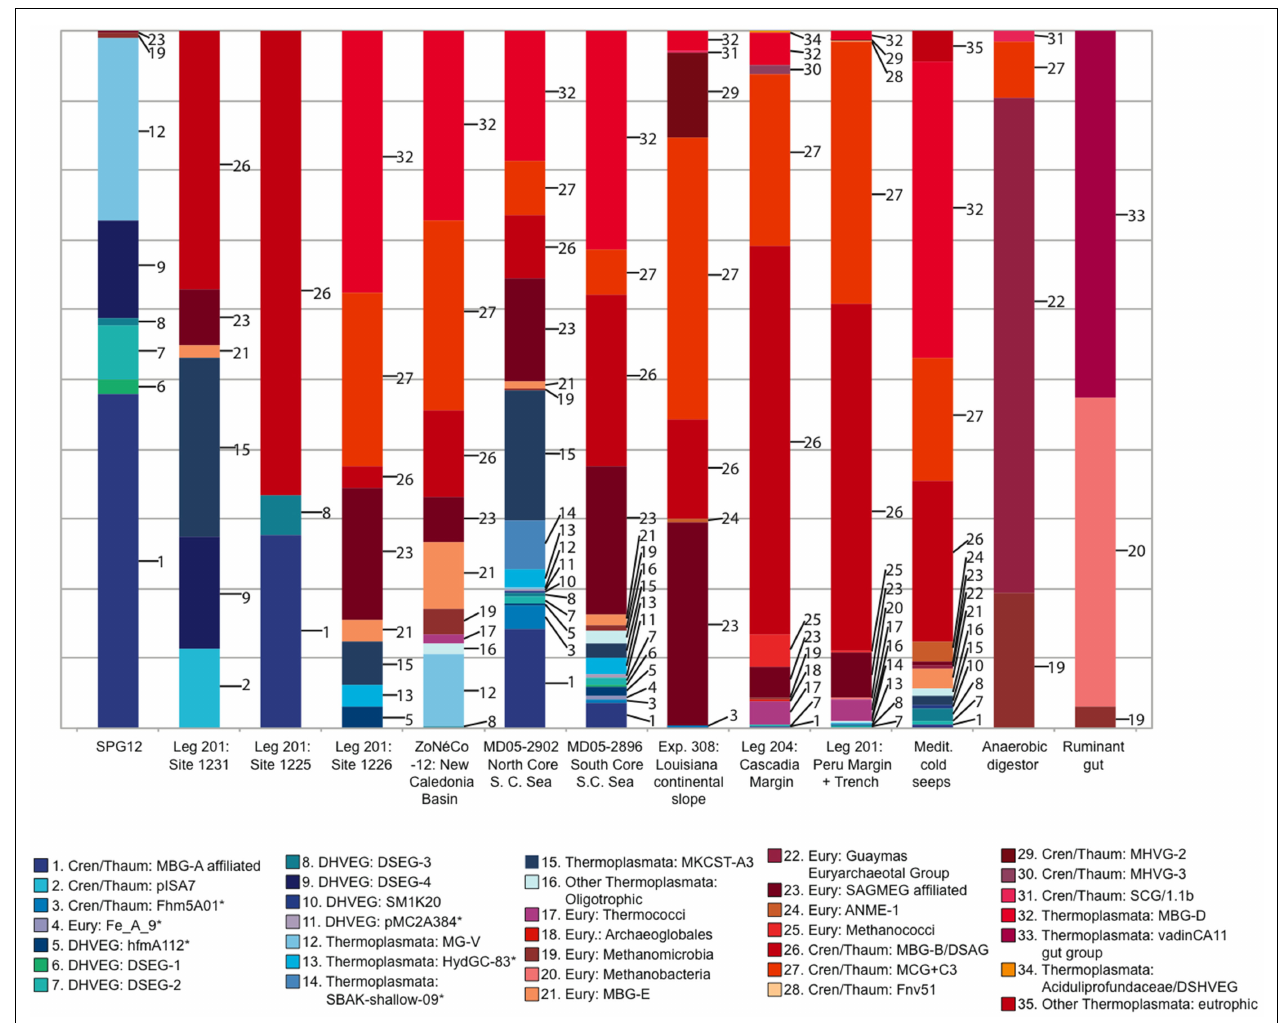
region (Brazos Basin, Peru Margin/Trench, Cascadia Margin, Mediterranean seeps). For Peru Margin/Trench sites, sequences labeled “Thermococci” (Inagaki et al., 2006) also include an unspecified number of Methanococci. As outgroup examples of anaerobic, extremely organic-rich environments, an anaerobic wastewater digestor (Chouari et al., 2005) and a ruminant foregut (Sundset et al., 2009) are